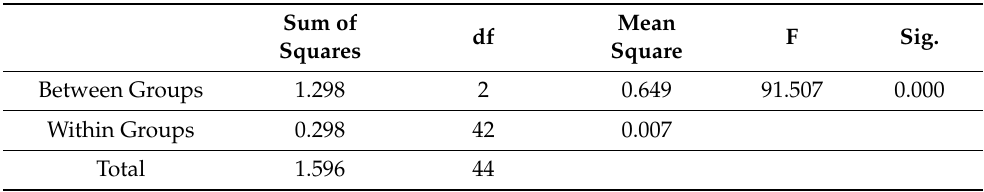
Table 5. ANOVA between groups.